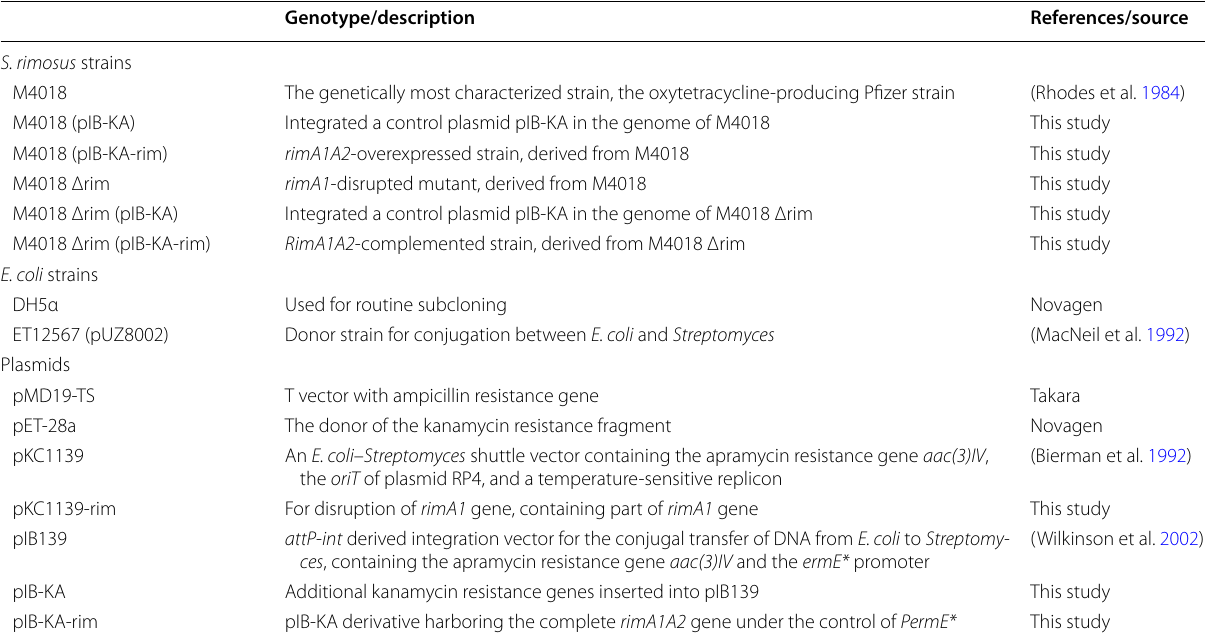
Table 1 Bacterial strains and plasmids used in this